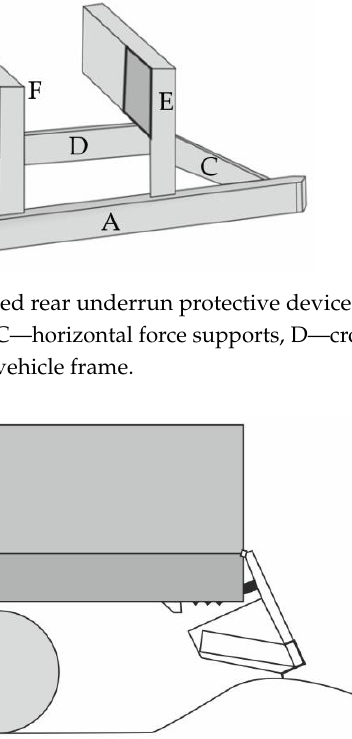
Figure 4. Principle of operation of the hinge used in the hinged RUPD.